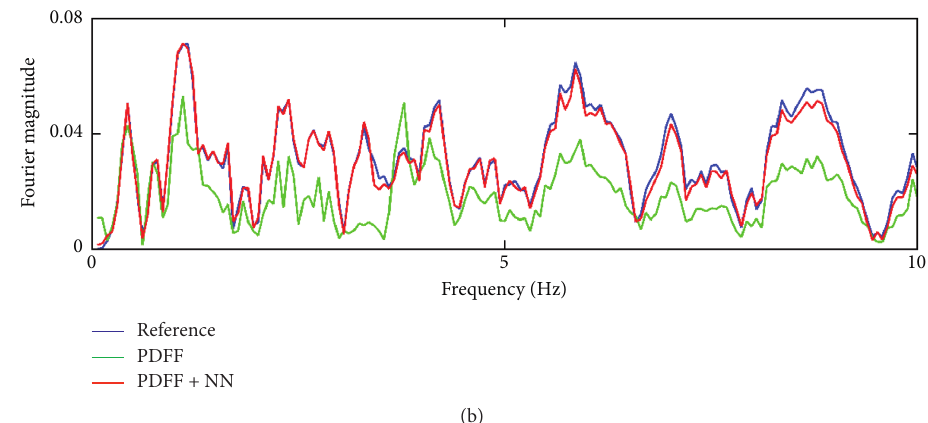
Figure 13: FFT comparison between the measured and the desired signal for the El Centro earthquake record (loaded table). Table 8: RMSE relative error values for different earthquake records in time and frequency domain analysis (loaded table). Ground motion